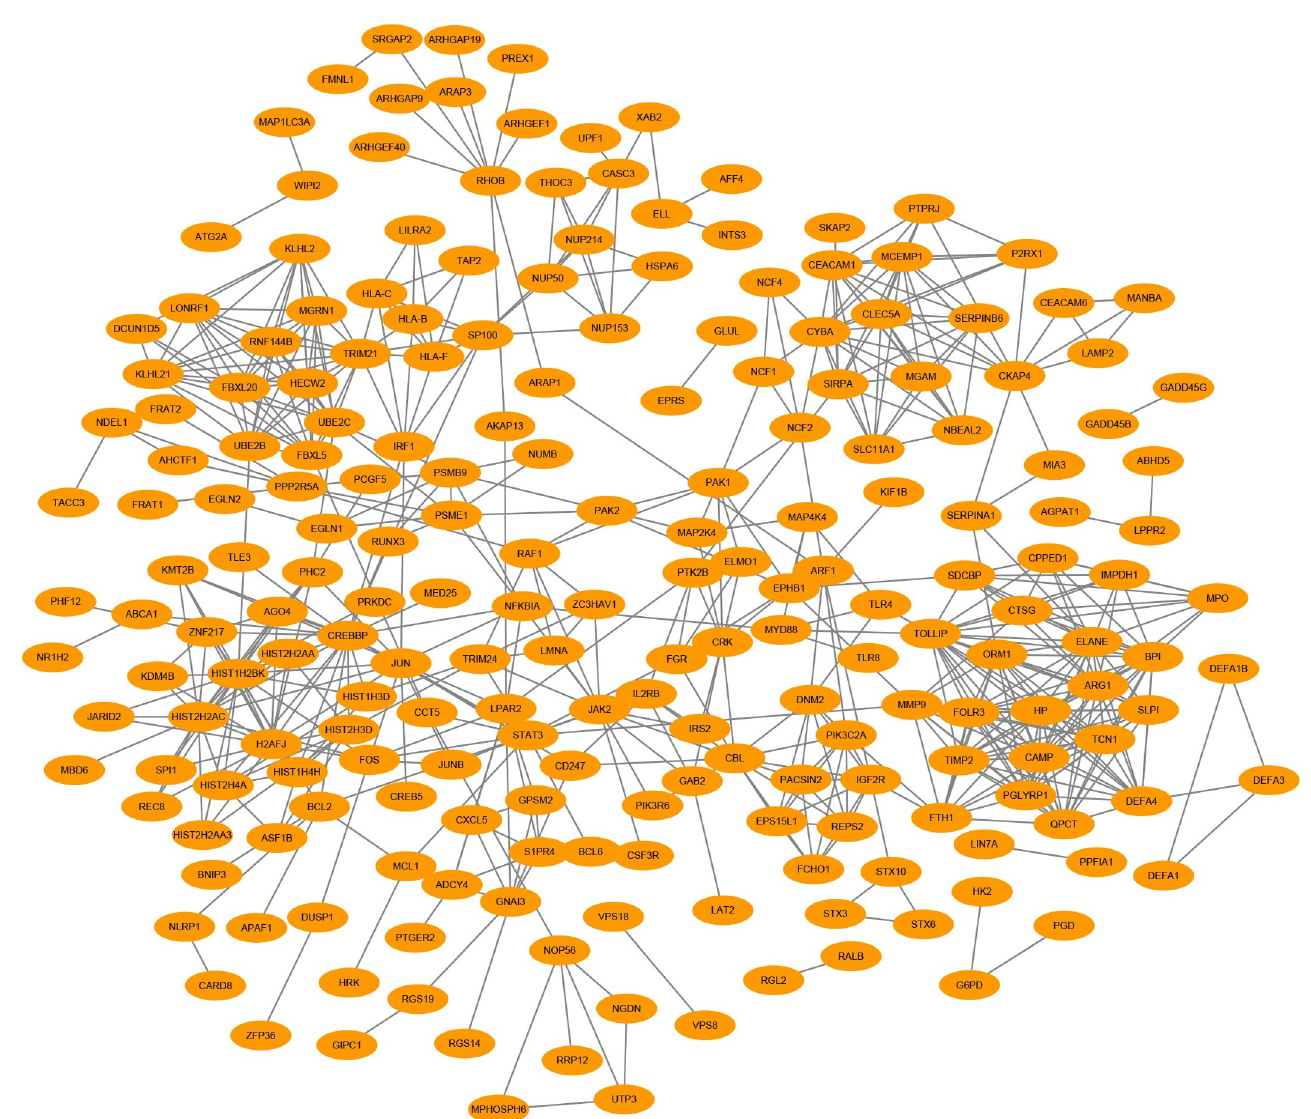
Fig 6. Female-specific PPI network in epilepsy. The PPI network included 213 nodes and 604 edges.